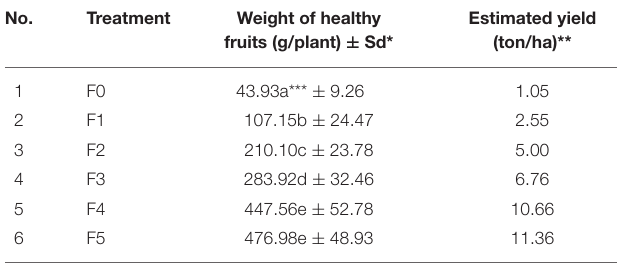
TABLE 6 | Effect of frequency of application of F6 to the weight of healthy fruits/plant on chili pepper cultivar Cabe Besar .